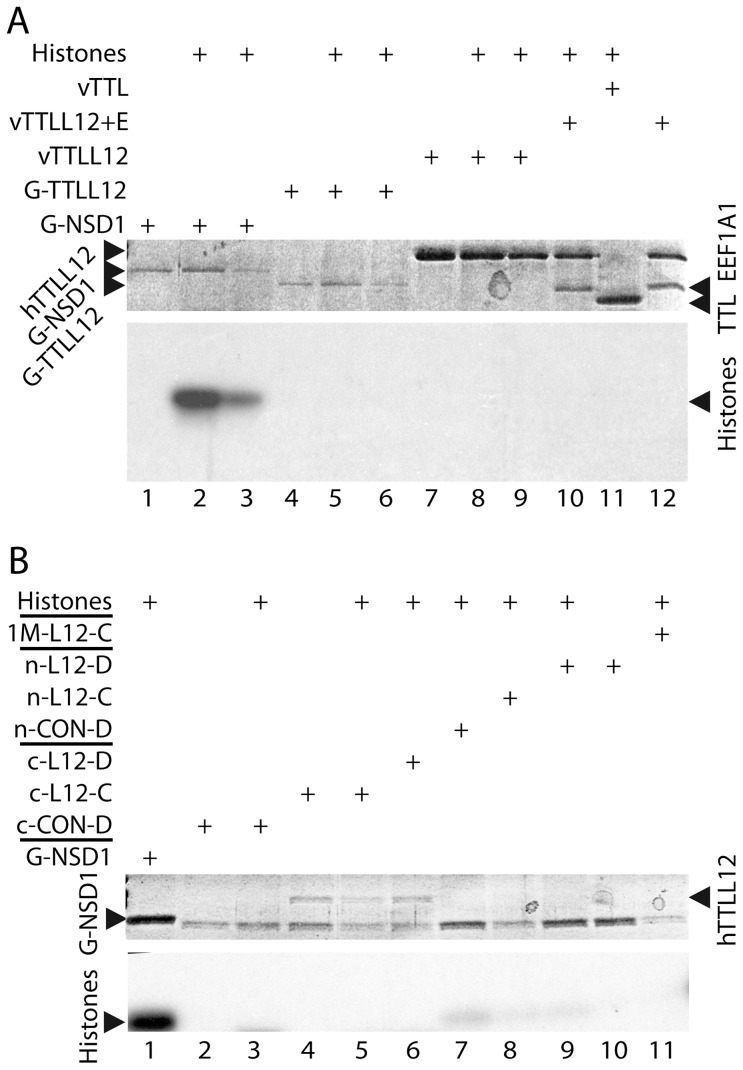
hTTLL12 lacks HMTase activity.The assays included histones purified from calf thymus (A, lanes 2, 3,5, 6, 8–11; B lanes 1, 3, 5–9, 11) as substrate and proteins to be tested for HMT activity that were purified from bacterial, viral and mammalian cell expression systems. The upper panels in each part (A & B) are Coomassie Blue stained SDS-polyacrylamide gels of the expressed proteins and the lower panels are the corresponding fluorograms centred on the core histones (Histones). The proteins tested for HMTase activity were expressed and purified from appropriate pGEX vector transformed E. coli [GST-NSD1 (1700–1987) (G-NSD1), GST-TTLL12 (50–250) (G-TTLL12)], recombinant vaccinia virus Ankara strain (MVA) infected mammalian cells [vTTLL12, vTTLL12 and vTTLL12 + E (a fraction that contains EEF1A1)] and HEp-2 cell clones transformed with pSG5-puro-Flag (CON-D) or pSG5-puro-Flag TTLL12 (L12-C & L-12-D). The HEp-2 proteins were purified from cytoplasmic (c-CON-D, c-L12-c, c-L12-D), nuclear (n-CON-D, n-L12-C, n-L12-D) and 1M KCl (1M-L12-C) fractions. 10 µl reactions were loaded on 15% SDS-PAGE gels. In A, the approximate amounts of protein used per reaction were: GST-NSD1 (1700–1987) (1 µg, lanes 1, 2; 0.5 µg, lane 3), GST-TTLL12 (50–250) (0.5 µg, lanes 4, 5; 0.25 µg, lane 6), TTLL12 (3 µg, lanes 7, 8; 1.5 µg lane 9), TTLL12 + EEF1A1 (2 µg, lanes 10, 12) and TTL (4 µg, lane 11). In B, they were GST-NSD1 (1700–1987) (2 µg, lanes 1, 12), TTLL12 (0.25 µg, lanes 4–6; 0.005 µg lanes 8–10, 0.001 µg lane 11). TTLL12 was not detected in the equivalent fractions purified from the control HEp-2 clone (CON-D). In B, lanes 2–11, the band migrating slightly faster than GST-NSD1 (1700–1987)) is IgH from the affinity column that is eluted under the harsh denaturing conditions used for sample preparation for SDS-PAGE.